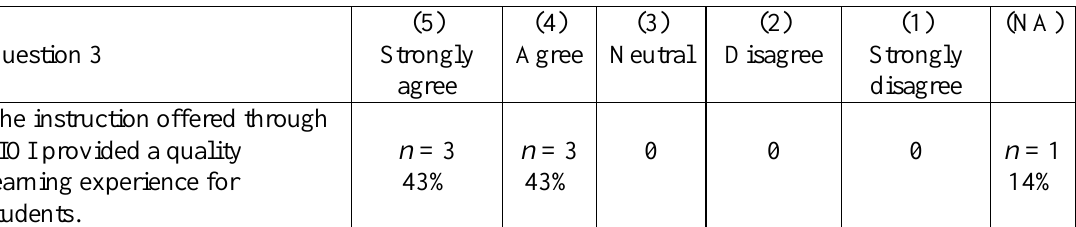
Respondents’ Comments on Quality